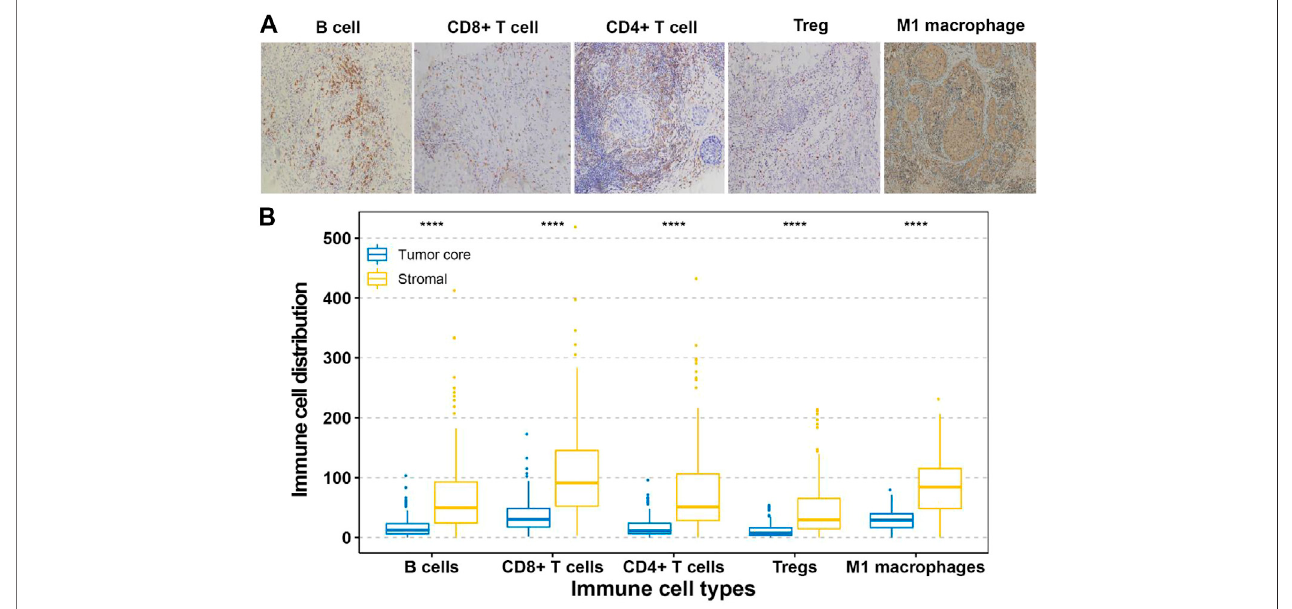
FIGURE2|(A) Tumorin fi ltrationofBcells,CD8 + Tcells,CD4 + Tcells,TregcellsandM1macrophagecellsinbreastcancerpatients. (B) Tumorin fi ltrationdensityof B cells, CD8 + T cells, CD4 + T cells, Treg cells and M1 macrophage cells in testing and validation cohorts.